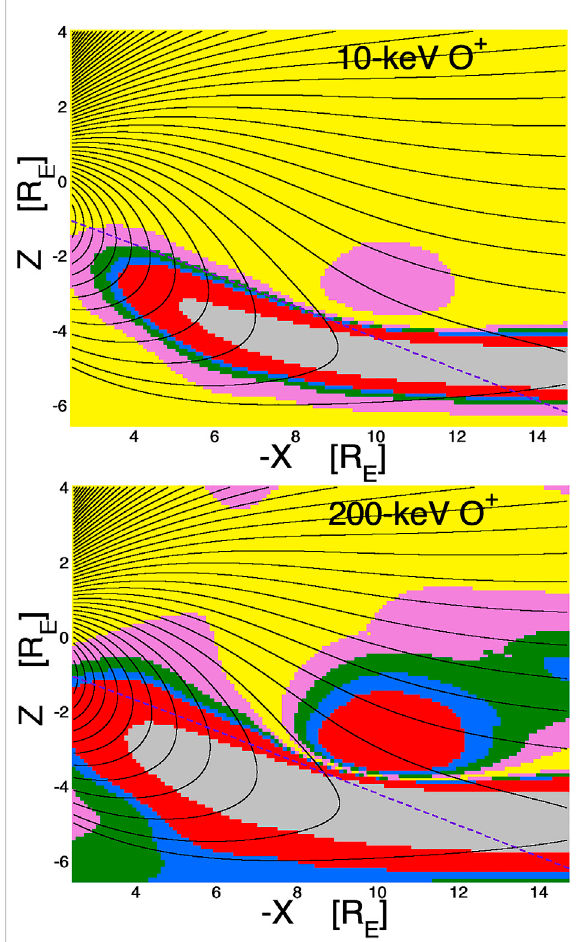
FIGURE 4 Loss-cone-shift maps for protons. Magnetic- fi eld lines in the nightside magnetosphere in the noon-midnight meridian are drawn as the black curves using the T96 magnetic- fi eld model. The colored shading is the calculated eastward shift of the localatmosphericloss conefor10-keVprotons(toppanel) andfor 100-keVprotons(bottompanels)basedontheT96magnetic- fi eld model. The color scheme is yellow (shift < 0.5 ° ), pink (shift 0.5 ° – 1 °